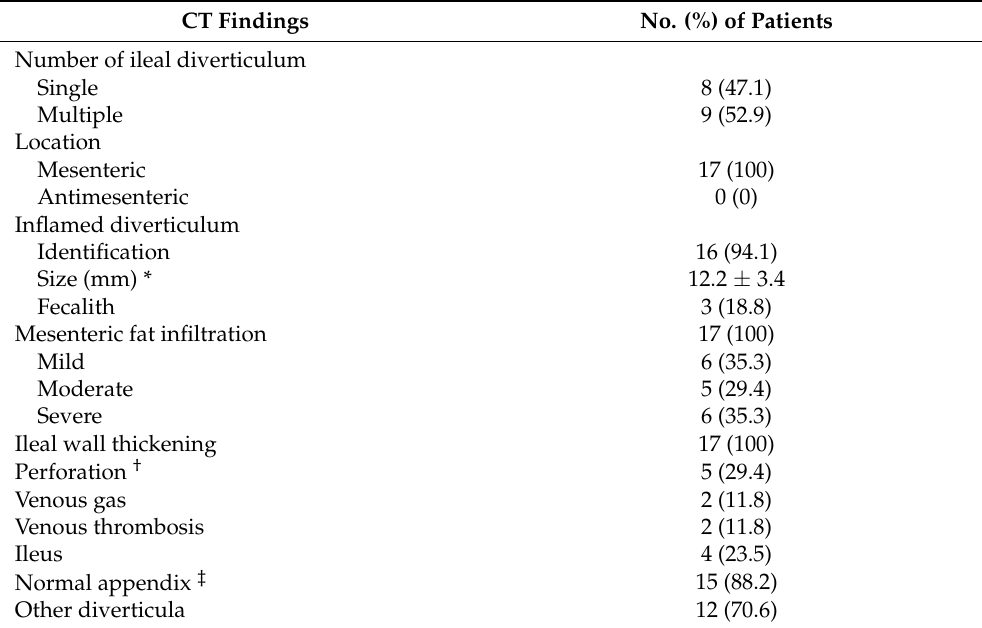
Table 2. CT findings for acute ileal diverticulitis.